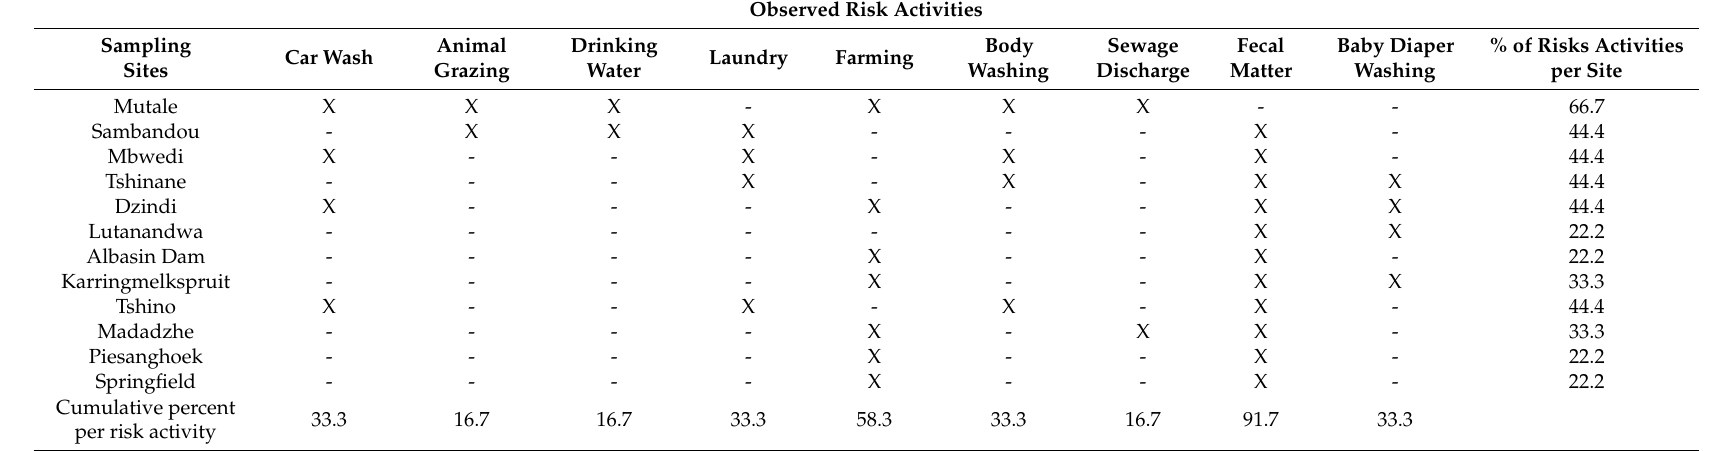
Table 1. Human activities observed at sampling